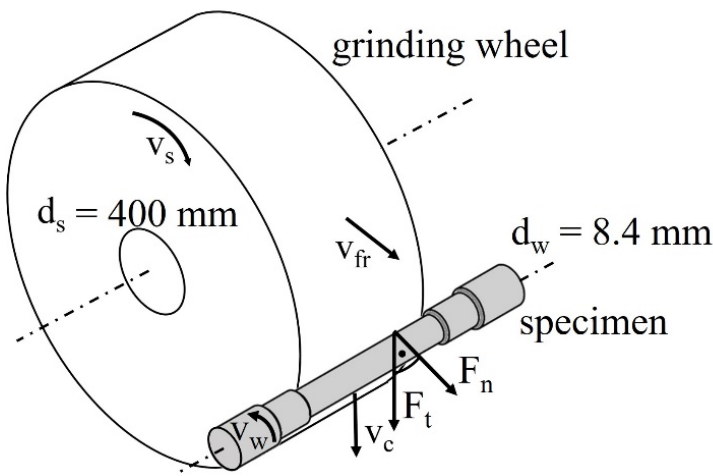
Figure 3. Sketch of grinding process with the grinding wheel and specimen.